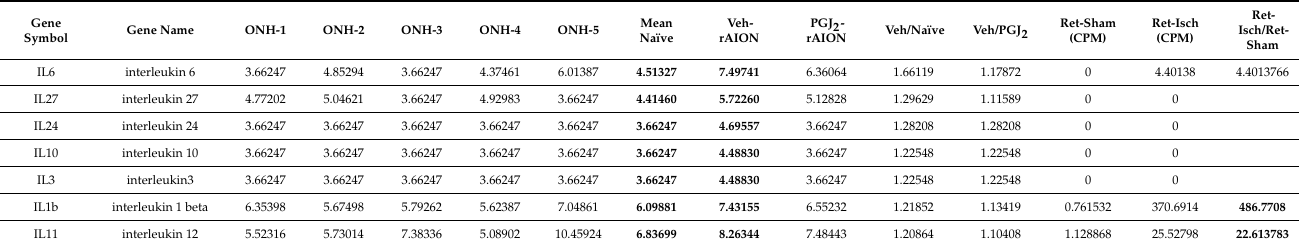
Table 4. List of interleukins with post-induction elevation > 2 fold (vehicle/naïve). Illumina sequence data for ONH are based on Deseq2-normalized (log 2 -fold relative levels) expressed in ONH RNA from individual naïve, mean naïve ( n = 5), rAION-vehicle-induced and rAION-PGJ 2 -treated animals, using a cutoff of <3.4. Normalization is based on Trimmed Mean Values (TMM) and normalized by EdgeR-cpm function with a cutoff of 2. Naïve retina (tetina-N) and ischemic retina (retina-Isch) are from [19] and expressed in counts per million (CPM). The ratio of expression in ischemic retina/sham retina values are shown in the last column. The two greatest ratio changes in retinal conditions are shown in bold. The total list is found in Supplemental Data Table S1. NF: not